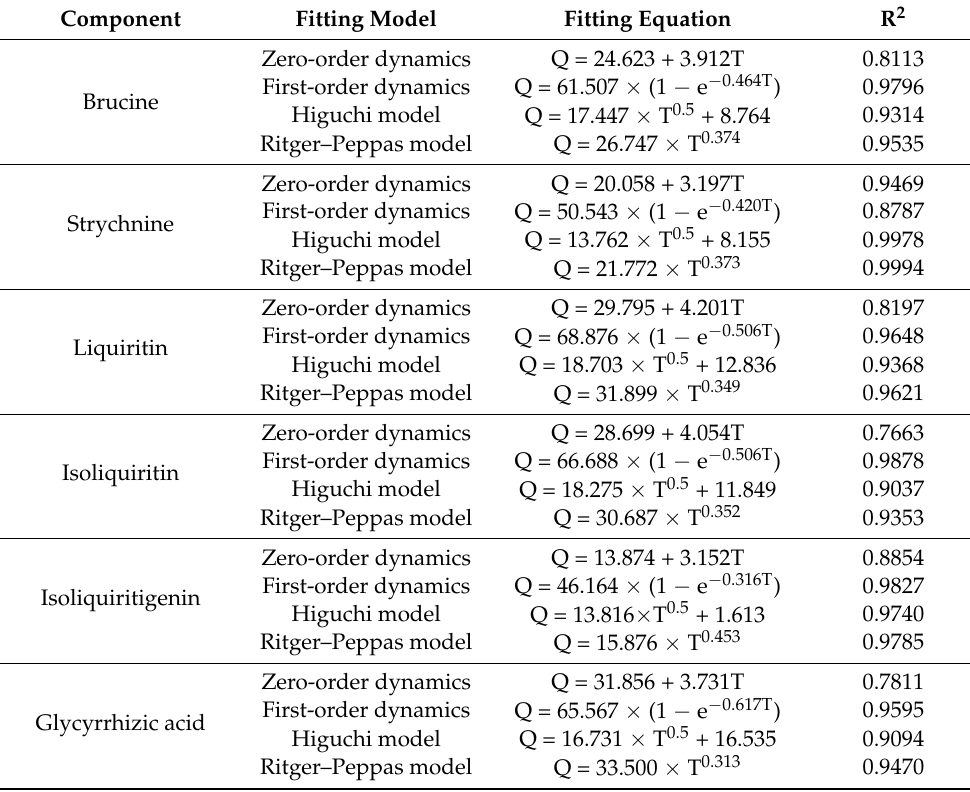
Table 7. Results of the cumulative release fit in distilled water.